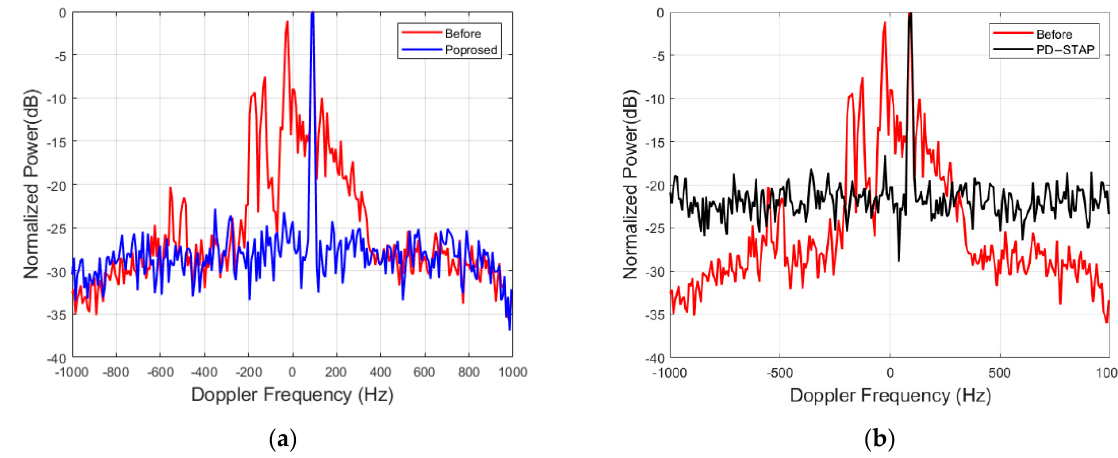
Figure 9. Output normalized SCNR of T1: ( a ) the proposed method; ( b ) PD − STAP.